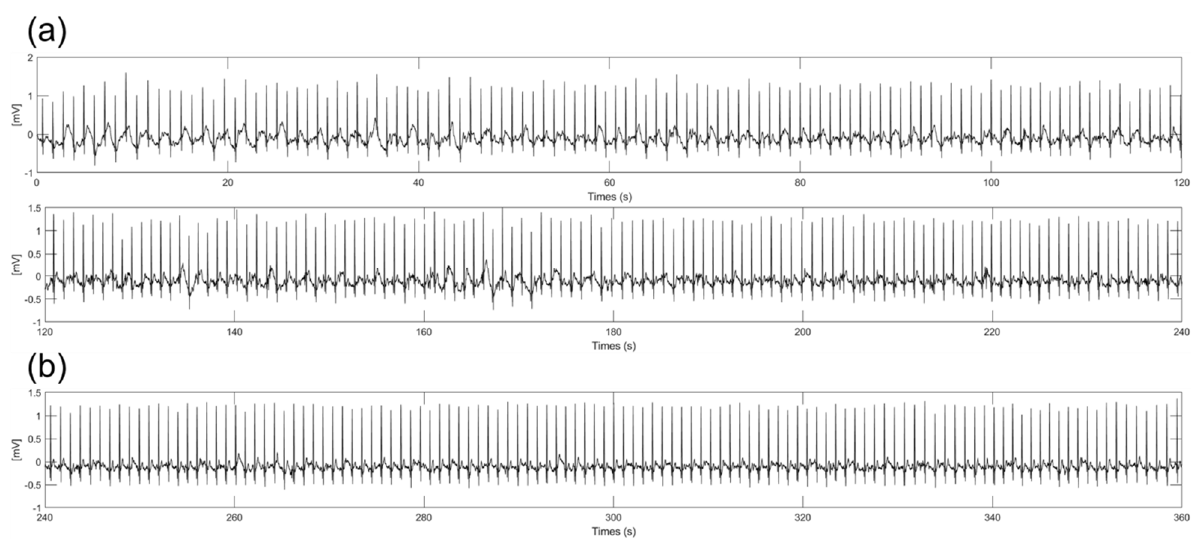
Figure 9. Six − minute ECG signals with spraying the saline on the skin. ( a ) From start to 4 min ( b ) From 4 to 6 min. ( b ) From 4 to 6